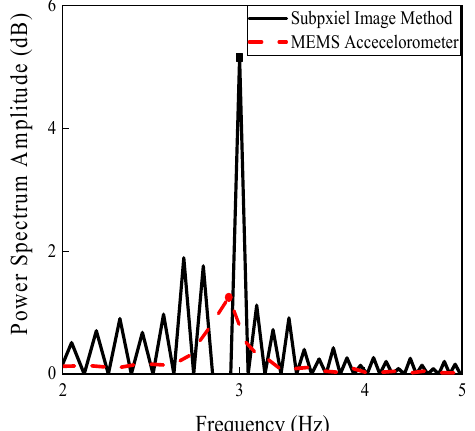
Figure 15. Natural frequency of the damaged steel beam through the MEMS accelerometer and subpixel image method.